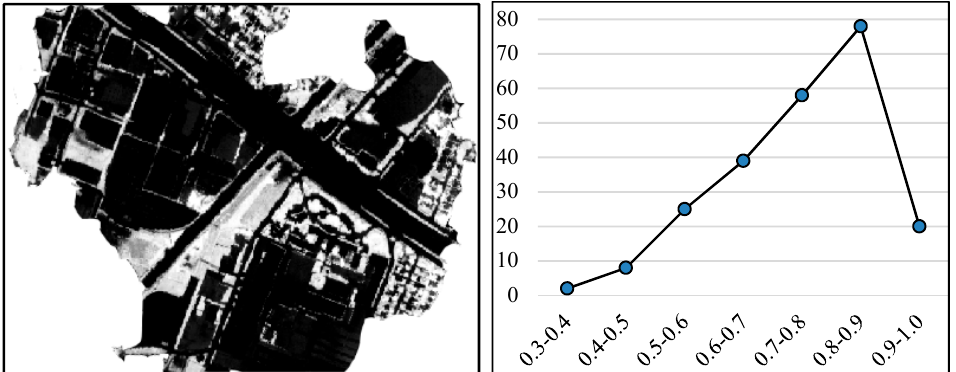
Figure 6. Normalized difference vegetation index (NDVI) imagery of the shadow area ( left ) and the distribution of vegetation samples in different intervals of the NDVI ( right ). Here, longitudinal and transverse axes represent the number of samples and NDVI, respectively.